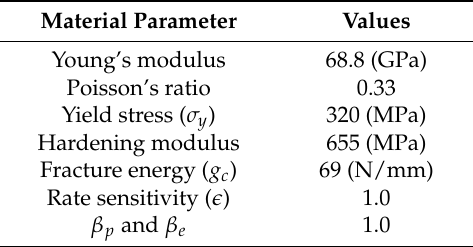
Table 1. Model parameters for the one ‐ dimensional simulations.